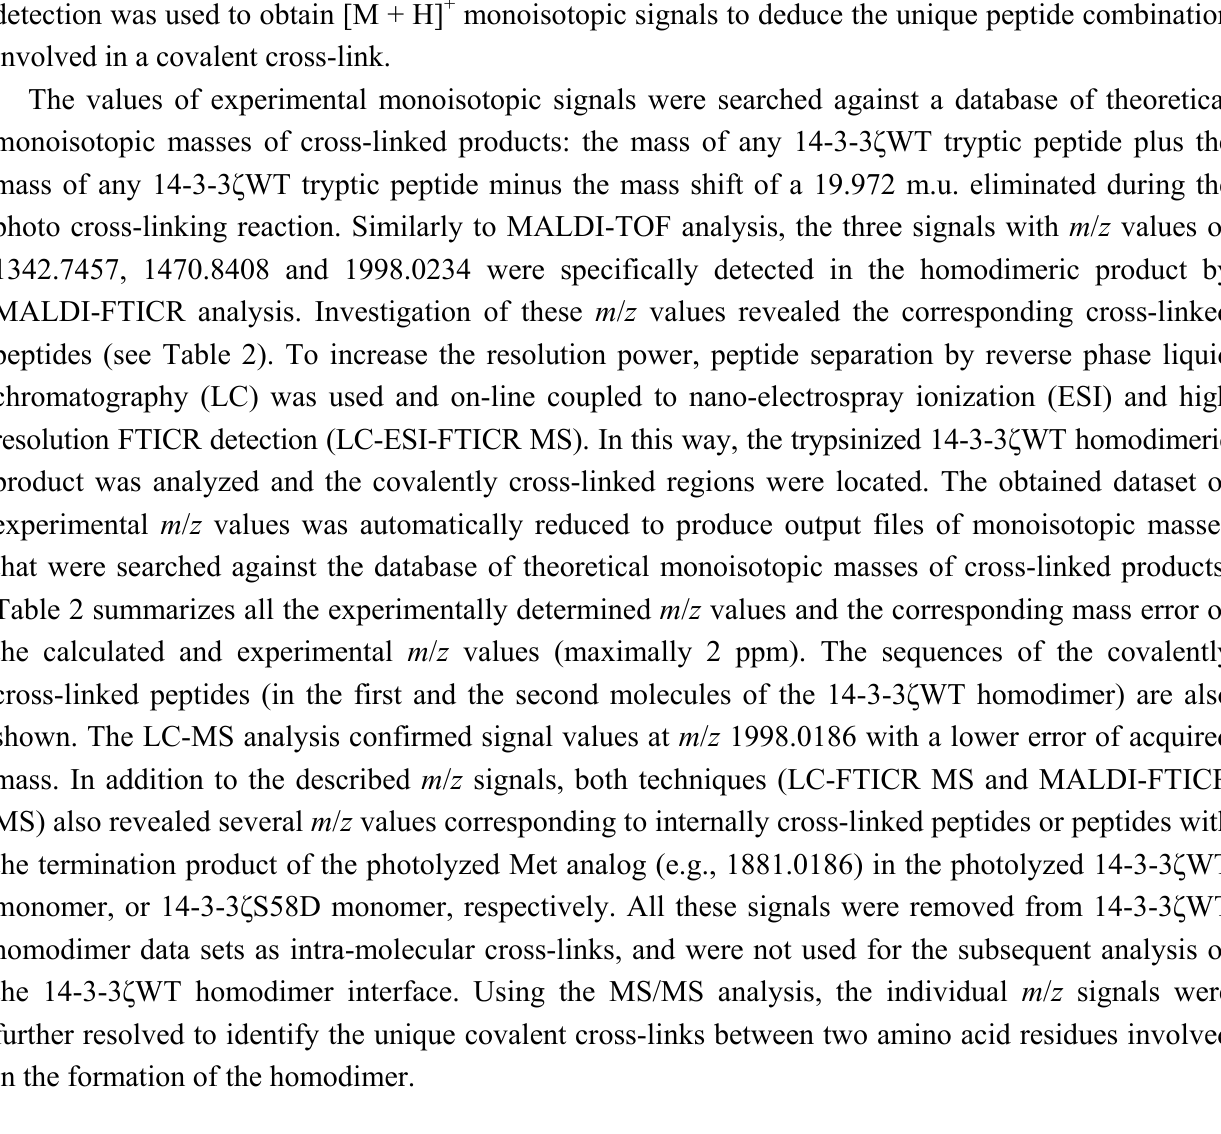
Table 2. Identified intermolecular photo cross-linked products in 14-3-3 ζ homodimer between molecule 1 and molecule 2 by * MALDI-FTICR (matrix-assisted laser